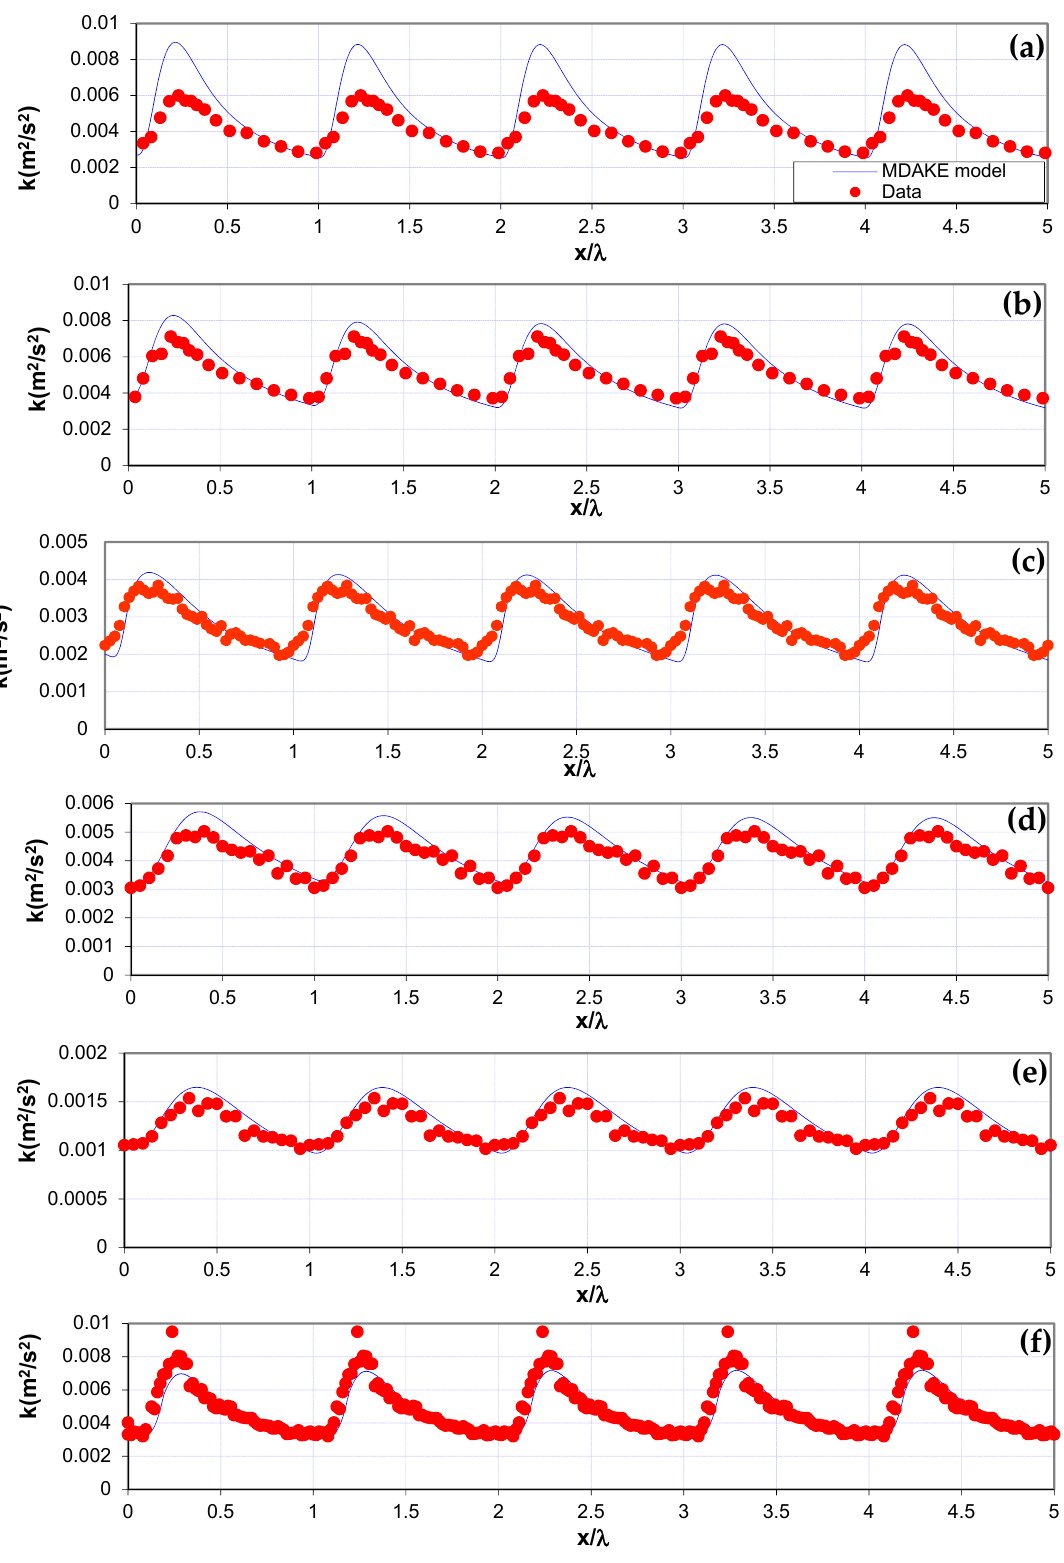
Figure 10. Depth-averaged predictions of MDAKE model using ζ k = 0.013 (solid line). Solid circles represent data of: ( a ) experiment T5, ( b ) experiment T6, ( c ) Run2, ( d ) Run4, ( e ) Run5, ( f ) experiment by Bennett and